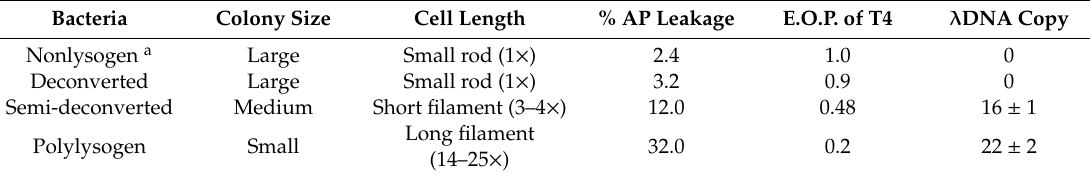
Table 6. Selected properties of the converted, deconverted, and semi-deconverted polylysogens. 1.